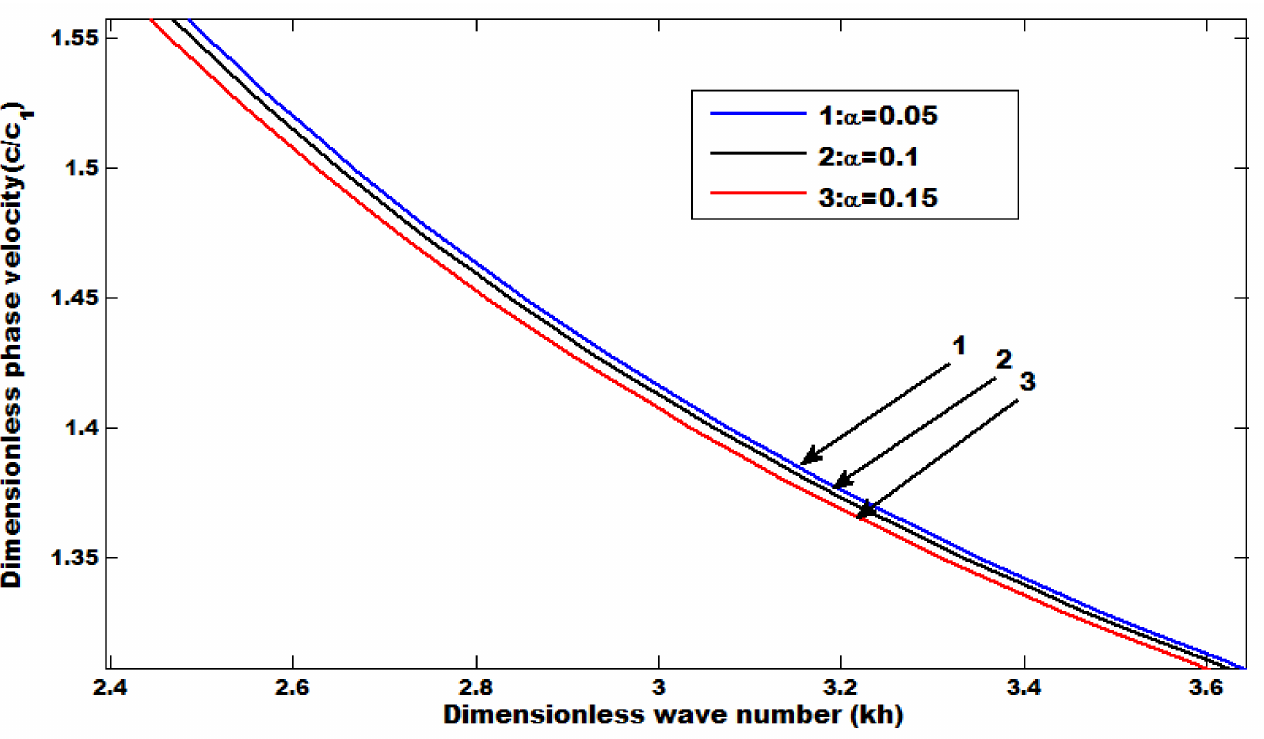
Figure 3. The phase velocity with wave number when a 1 = 0.1, p = 0.01, a 2 = 0.2, h = 0.04, m = 0.08, β = 0.1.